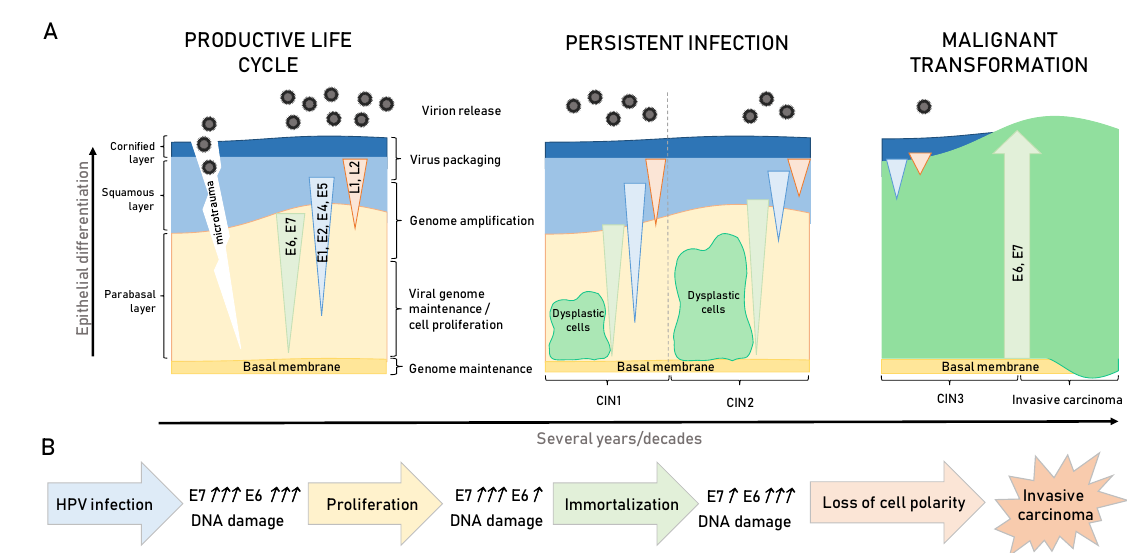
Figure 2. From HPV infection to malignant development. ( A ) HPV virions infect cells in the basal layer of the cervical epithelium through microtrauma. The expression of individual genes follows the differentiation of epithelial cells from the basal layer to the squamous cell layers of the epidermis with virion release from the upper layers. In the initial stage of infection, early genes are expressed, and they regulate viral replication and transcription. In persistent infection, cells in the parabasal layer become dysplastic, but the productive viral life cycle continues, with the area of cell proliferation becoming wider along with the progression of cervical intraepithelial lesions (CIN) from CIN1 to CIN2. If the host’s immune system does not resolve the viral infection, and it persists for a long period of time (several years), this can lead to pre-cancerous lesions and then to cancer development. When dysplastic cells encompass the entire thickness of the epithelia (CIN3), the productive viral life cycle is present only in the narrow area at the surface if at all. With malignant transformation, productive viral life cycle becomes abortive (green triangle—E6, E7 expression; blue triangle—E1, E2, E4, E5 expression; pink triangle—L1, L2 expression). ( B ) The expression level of viral oncoproteins E6 and E7 during HPV carcinogenesis varies as shown. The viral oncoproteins E6 and E7 mainly act on the tumour suppressors p53 and pRb, respectively. E6 binds and degrades p53 via ubiquitin-ligase E6AP, while oncoprotein E7 binds and degrades pRb via cullin-2 ubiquitin ligase complex. In the long term, infection with HR HPV types leads to uncontrolled cellular division (proliferation) without the possibility of repairing genetic defects leading to genetic instability, cell immortalization, and loss of cellular polarity, resulting finally with malignant transformation of host cells.